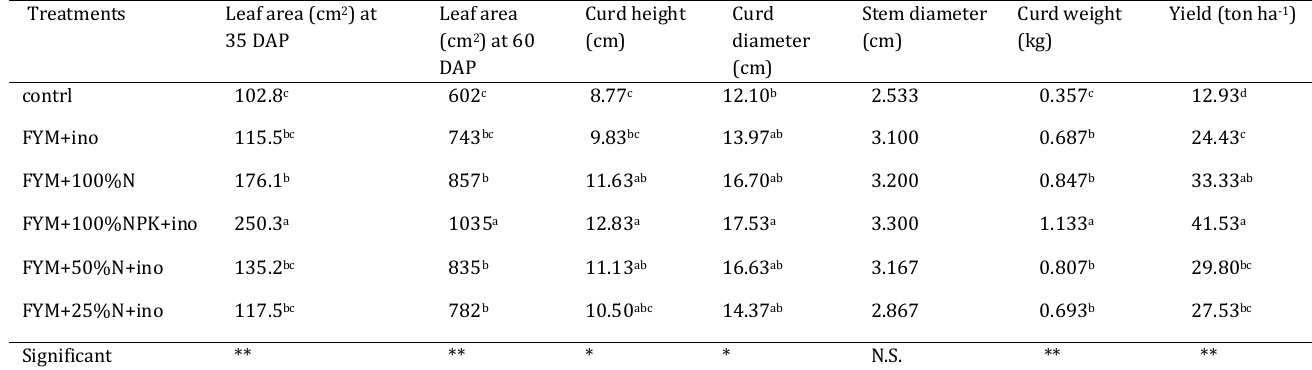
Table 3: Effect of Azotobacter on plant height, leaf no., plant spread, leaf area and yield of cauliflower in Lamjung 2015/16